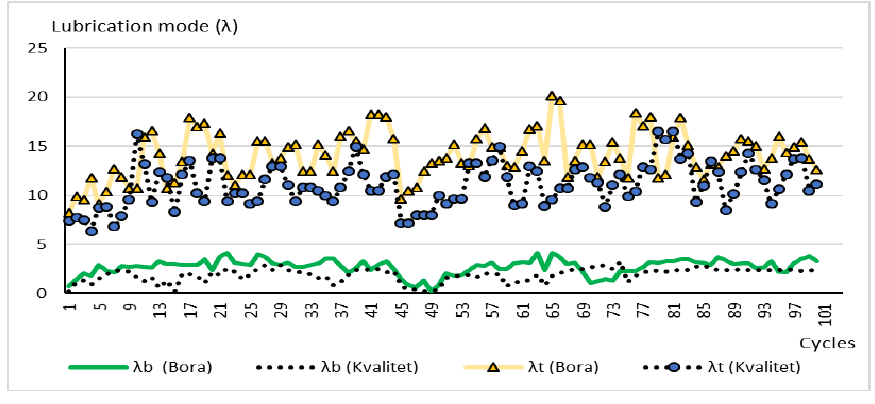
Fig. 4. The kinetics of change in lubrication modes in tribological contact (Classification of lubrication modes by λ: